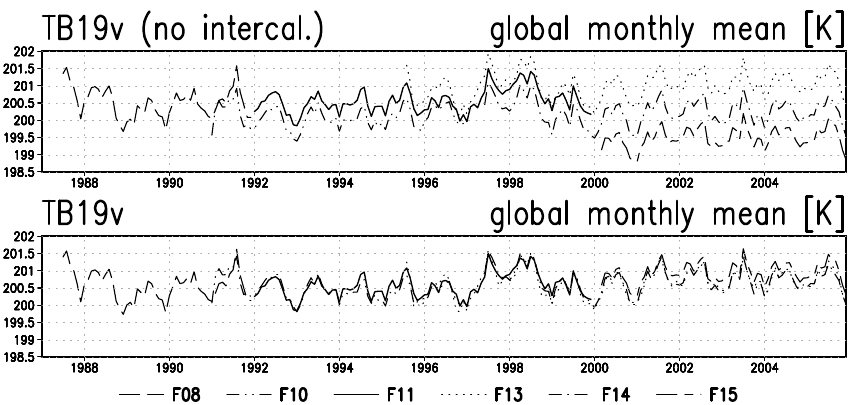
Figure 7. SSM / I inter-sensor calibration as applied in the HOAPS processing chain, exemplarily shown for the time series of monthly global mean TB 19v of each SSM / I without (top) and with (bottom) inter-sensor